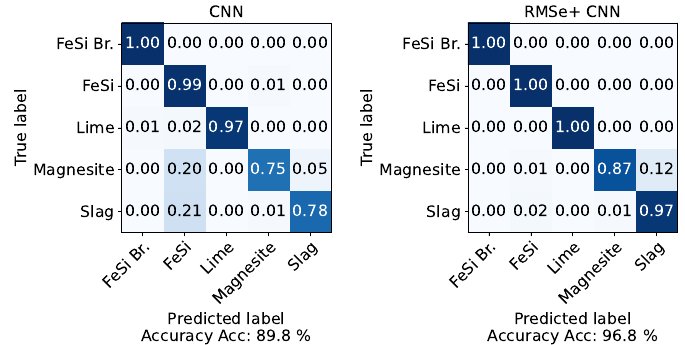
Figure 15. Achieved classification performance and confusion matrixes on robustness test dataset: CNN ( left ) and CNN with RMSe preprocessing ( right